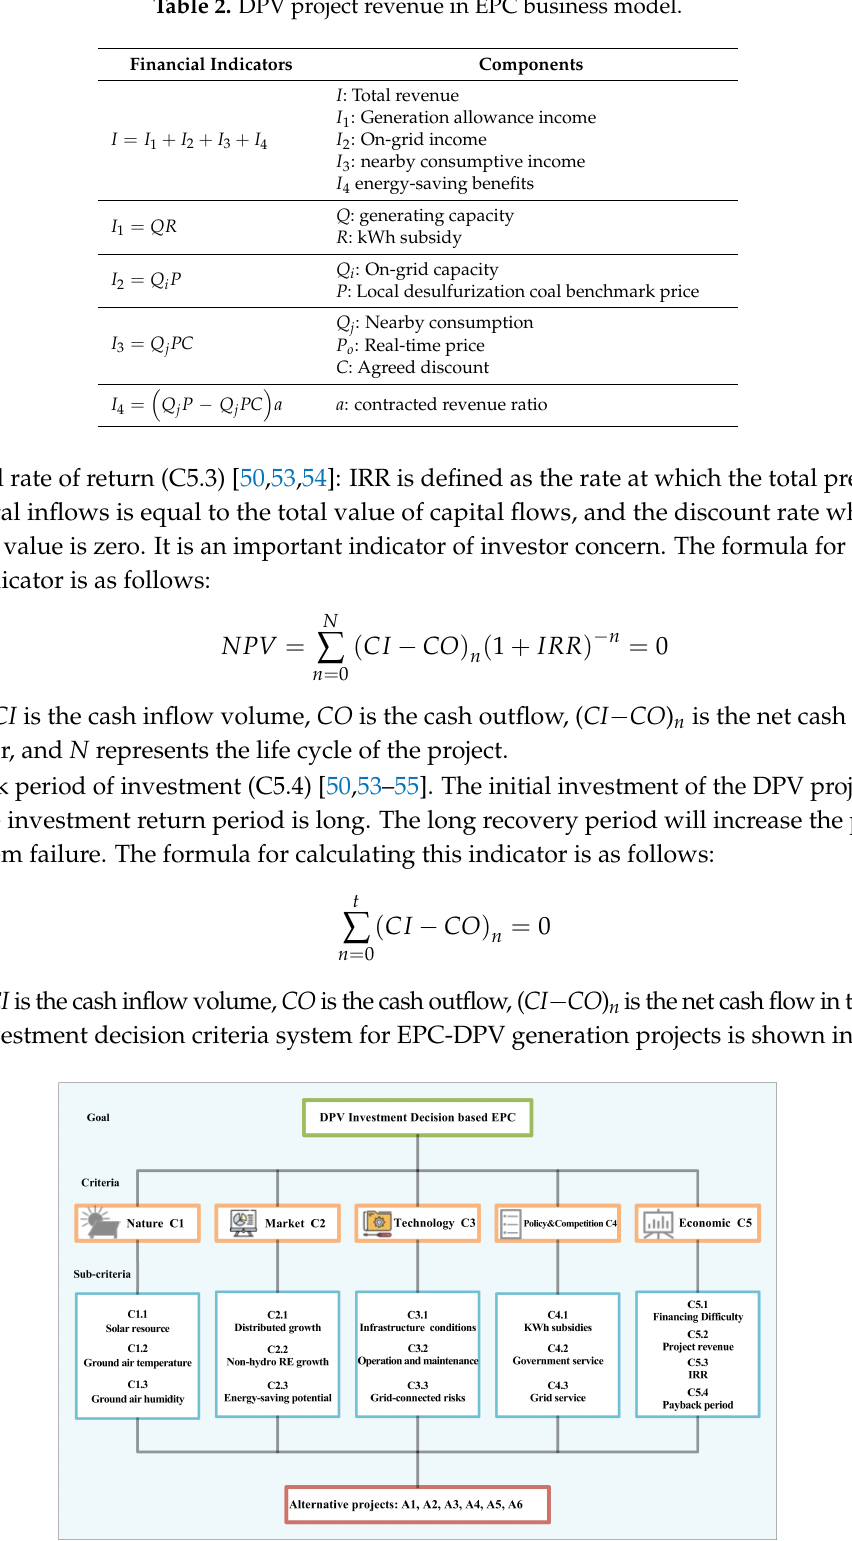
Table 2. DPV project revenue in EPC business model.